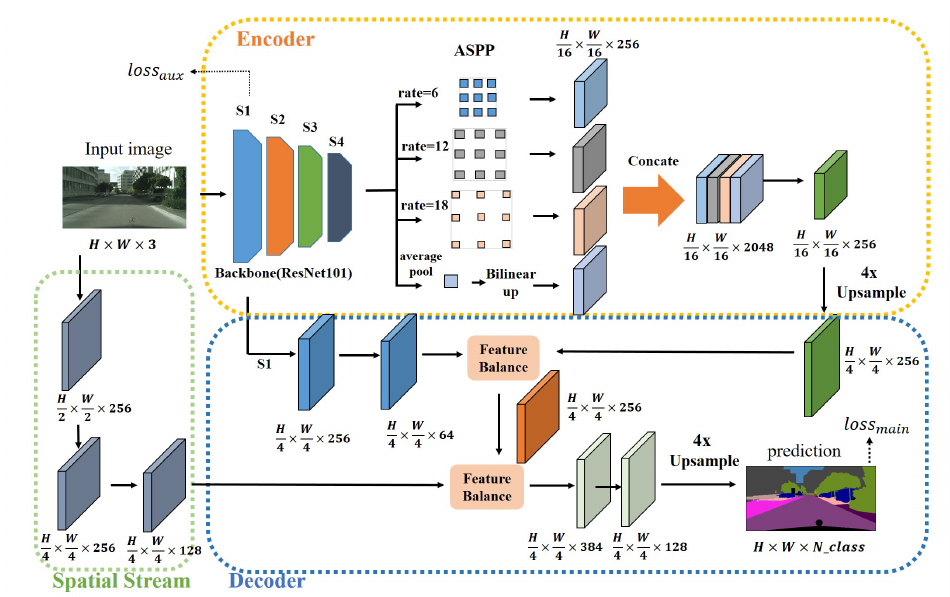
Figure 2. The overall structure of IFBFNet. There are three parts: encoder, decoder, and spatial stream. The encoder is composed of a backbone network and ASPP to extract rich high-level semantic information. In the decoder, we added inter-level feature balanced fusion module into each skip-connection structure. The spatial stream supplements more low-level spatial